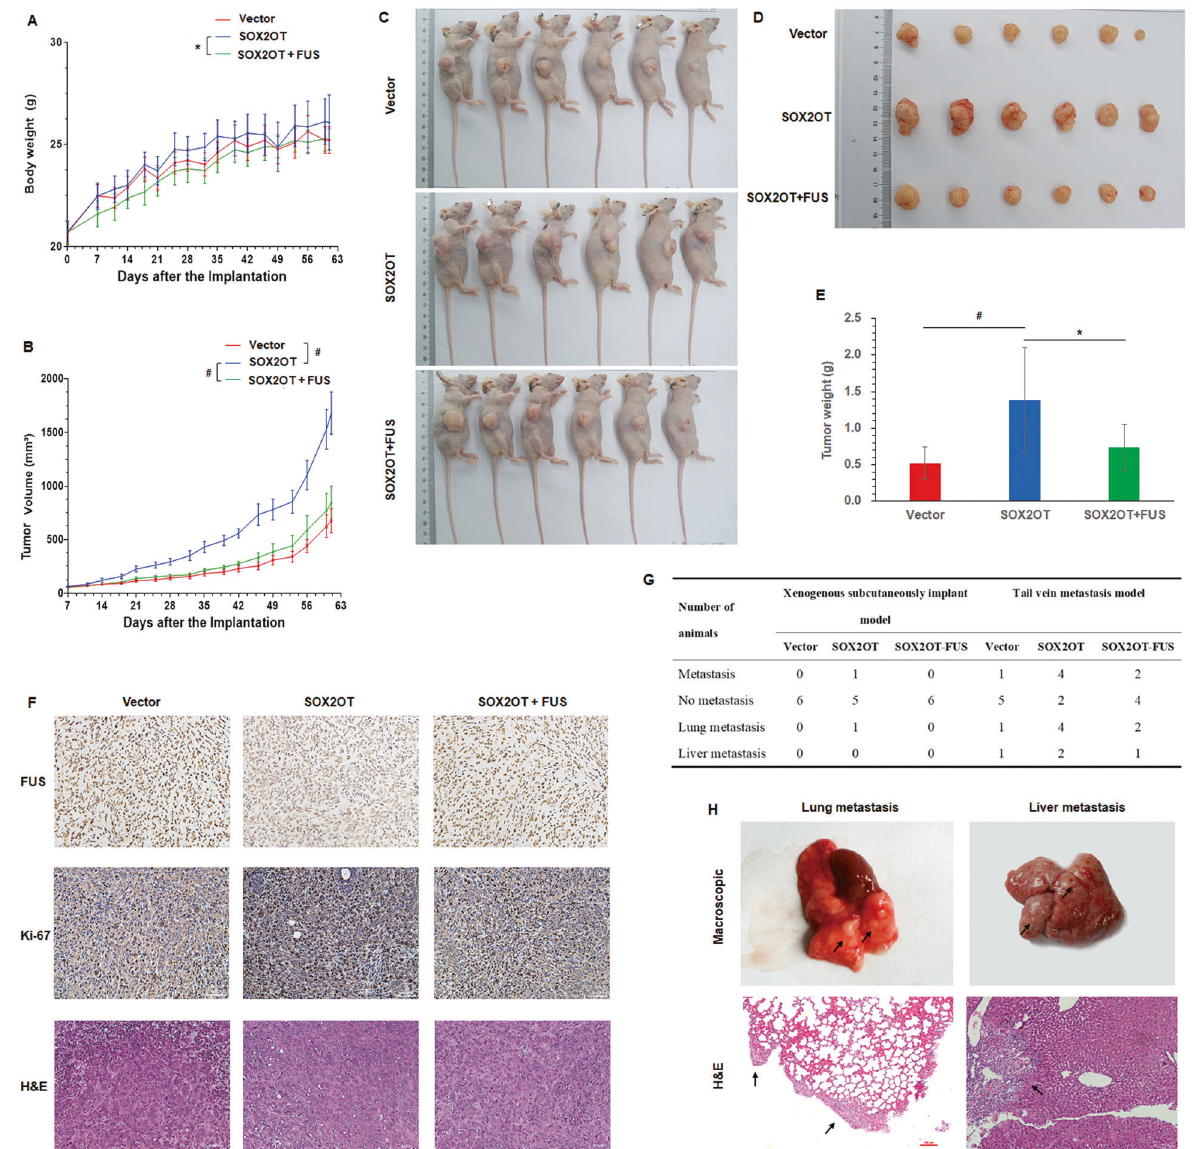
Fig. 1 SOX2OT – FUS regulatory axis promotes in vivo tumor formation and metastasis ability of pancreatic cancer cells. Body weight diversity curves ( A ) and tumor growth curves ( B ) in mice over time after subcutaneous injection with 1 × 10 6 of the indicated cells. In vivo ( C ) and in vitro ( D ) photos of tumors at the end of the experiment in subcutaneous tumorigenesis models. E Tumor weight of the subcutaneous tumors taken from mice. F HE staining and immunohistochemistry analysis of FUS and Ki67 in subcutaneous tumors. Magni fi cation, ×100. G Metastasis in subcutaneous tumorigenesis models and tail vein metastasis models. H In tail vein metastasis models, lung and liver metastases were evaluated by macroscopic observation and by histomorphology under microscopy. Scale bar, 100 μ m. The arrows indicate the metastases. (* represents p < 0.05, # represents p < 0.001, compared with the control